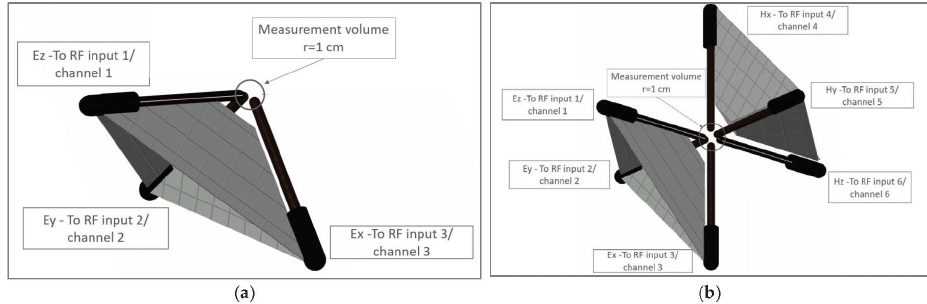
Figure 1. Schematic description of the proposed E-field sensor ( a ) and E- and H-field sensor ( b ).